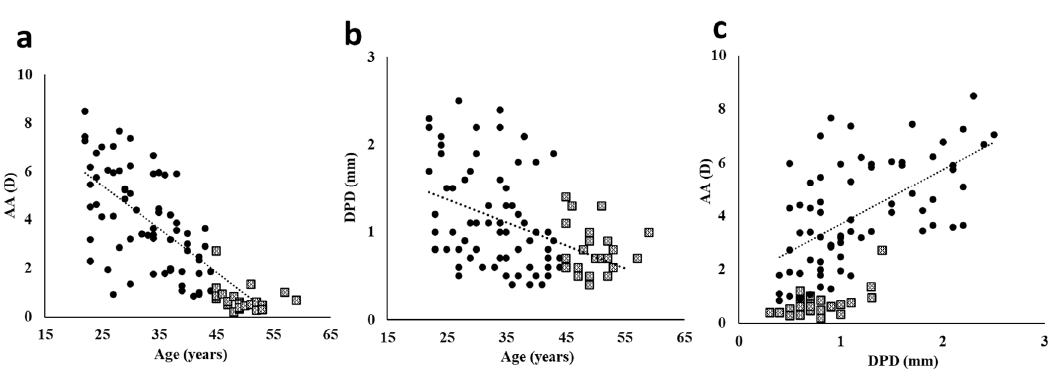
Figure 2. Single correlation curve of age and accommodation in 95 participants. ( a ) AA vs age (correlation coe ffi cient, − 0.771; p ≤ 0.01; ( b ) AA vs. DPD (correlation coe ffi cient, − 0.420; p ≤ 0.01); and ( c ) DPD vs. age (correlation coe ffi cient, 0.634; p ≤ 0.01). AA: amplitude of accommodation, DPD: di ff erence in pupillary diameter. • , young group; (cid:3) , older